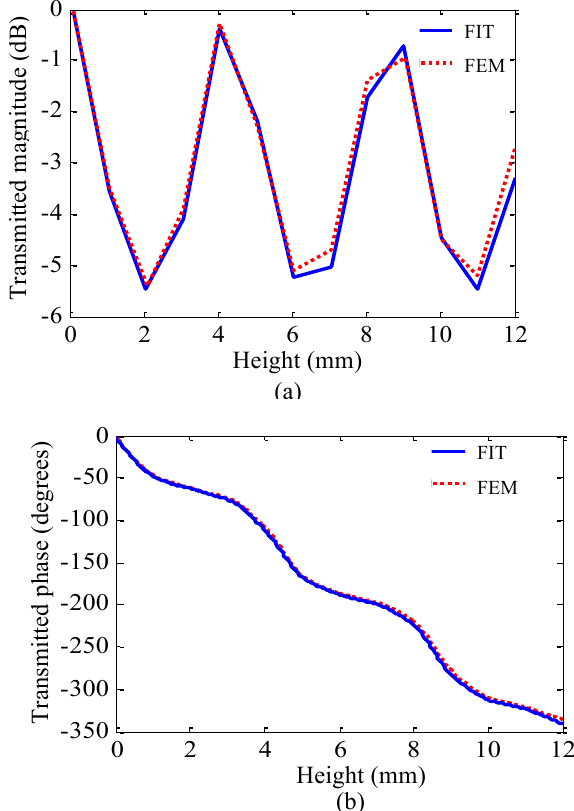
Figure 20: The variation of transmission magnitude (a) and phase (b) versus